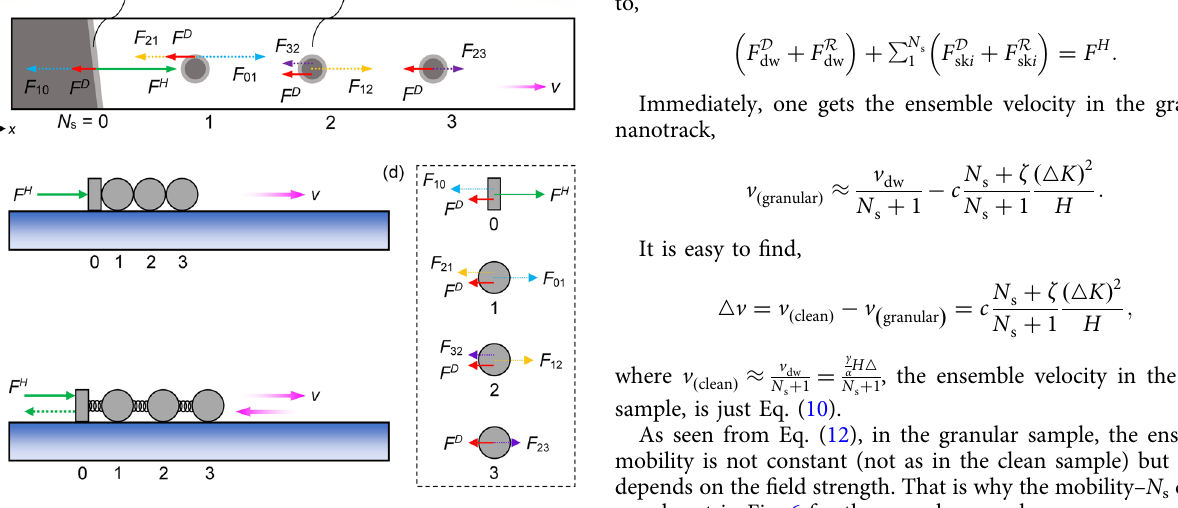
Fig. 7 Force balance on an ensemble of rigid bodies in steady motion. a Train of domain wall – skyrmions in steady motion. Here, the number of skyrmions N s = 3 is taken as an example and the transverse forces are ignored. b Uniformly moving train of cuboid – balls in direct contact. c Uniformly moving train of cuboid – balls linked by springs. d Forces on every entity. For the domain wall – skyrmions train, F H is the fi eld-induced force, which only acts on the domain wall; F D are the dissipative forces, which act on every magnetic entity in the ensemble; F i , i + 1 and F i + 1, i ( i = 0, 1, 2, … N s ) are a pair of action and reaction forces, which arise from dipolar and/or exchange interactions between the magnetizations in neighboring magnetic entities. For the cuboid – balls train, F H is an applied pushing or pulling force, which directly acts on the cuboid; F D are the friction forces, which act on every entity in the ensemble; F i , i + 1 and F i + 1, i ( i = 0, 1, 2, … N s ) are the action and reaction forces, which arise from direct contact of neighboring cuboid and balls or from mediation of the spring. Steady motion means that the entire ensemble moves at a uniform velocity v